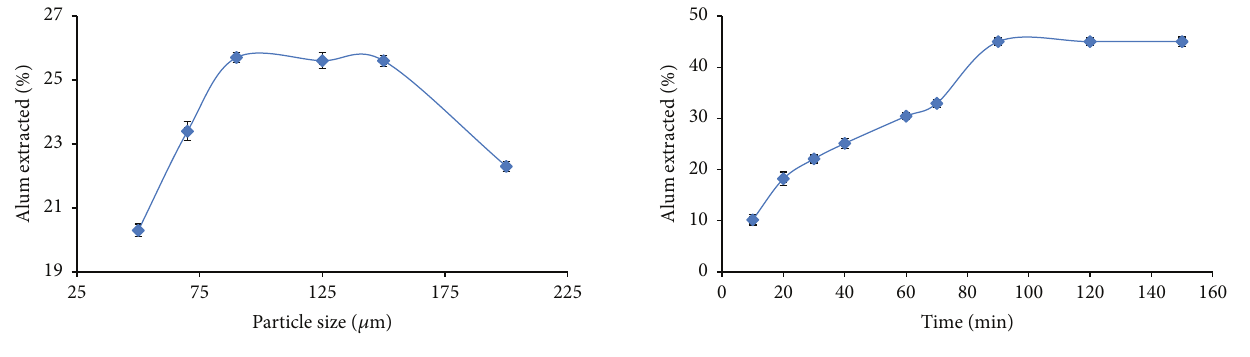
Figure 5: Effect of particle size on extraction of aluminum sulphate (time: 1.5 h; leaching temperature: 100 ∘ C; acid concentration: 4 M; error bar = ± SD; and 𝑛 = 3 ).